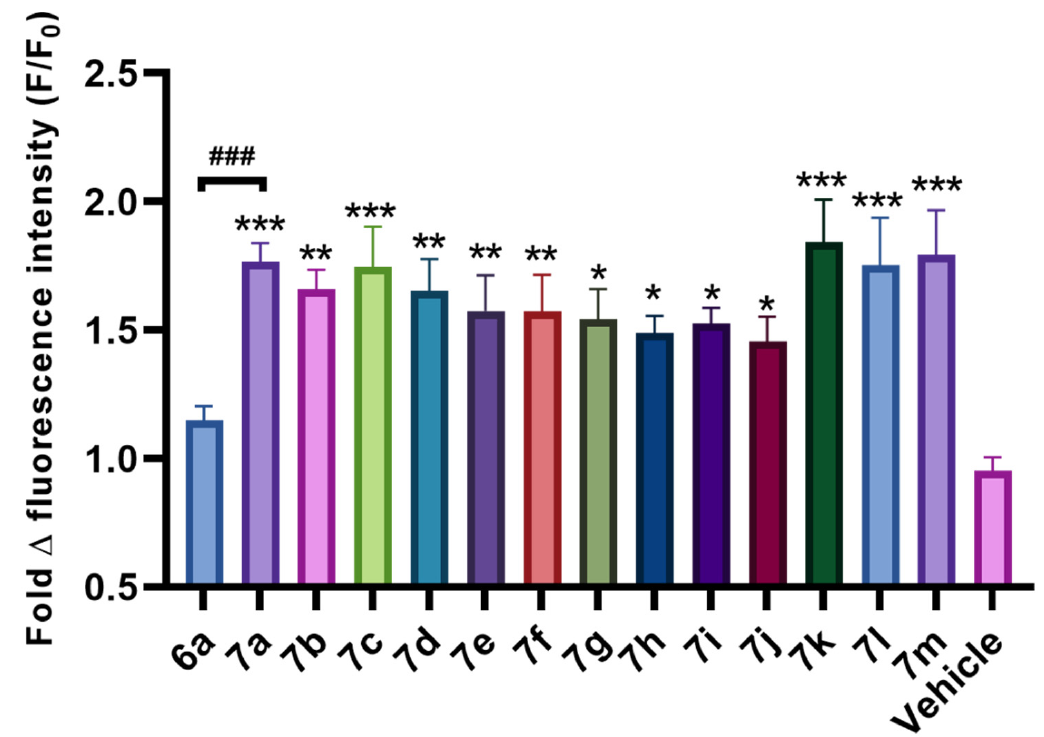
Figure 2. Compounds donate NO to DAM-FM in HEK293S cells. HEK293S cells were treated with 100 µ M of each compound and incubated for 2 h. NO release was detected using DAF-FM and fluorescently imaged in the fluorescein channel. NO release was quantified using Perkin Elmer Columbus software by comparing mean fluorescence intensity prior to and 2 h after the addition of compound. Data are expressed at mean ± s.e.m of five independent experiments in triplicate. * p < 0.05, ** p < 0.01, *** p < 0.001 compared to vehicle by one-way ANOVA with a post-hoc Dunnett’s test. ### < 0.001 for 6a and 7a when compared by Student’s unpaired t -test. The mean of each com- pound ( 7a – m ) was compared to each other by one-way ANOVA with post-hoc Tukey’s multiple comparisons test; no significant differences were observed.